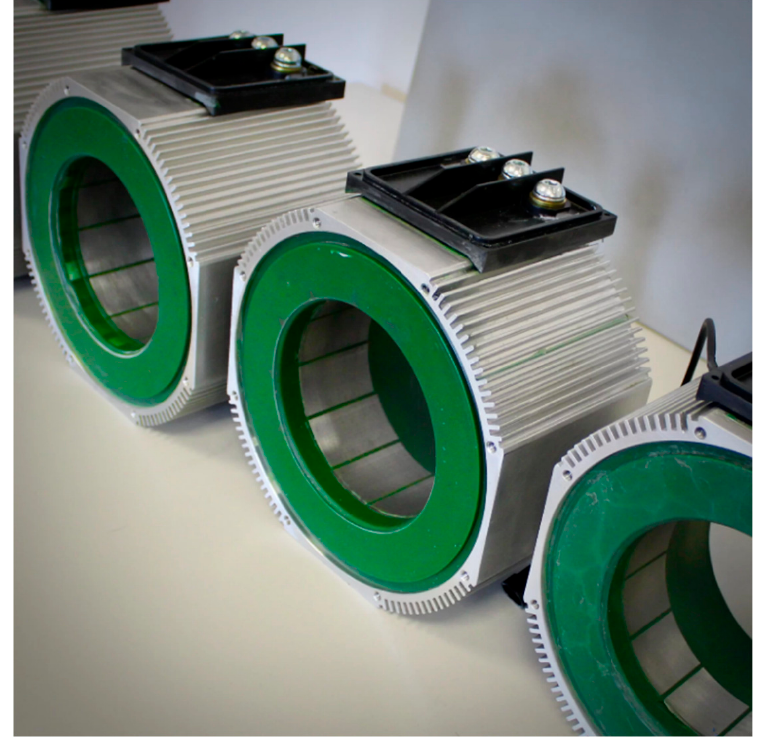
Figure 4. The winding ends sealed with epoxy resin [15].